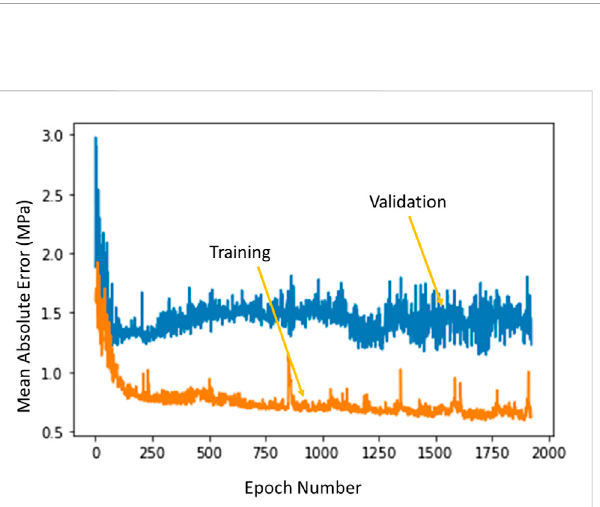
FIGURE 7 Comparison between FE results and DL predictions. Python (3.7, https://www.python.org/) was used to create this fi gure.